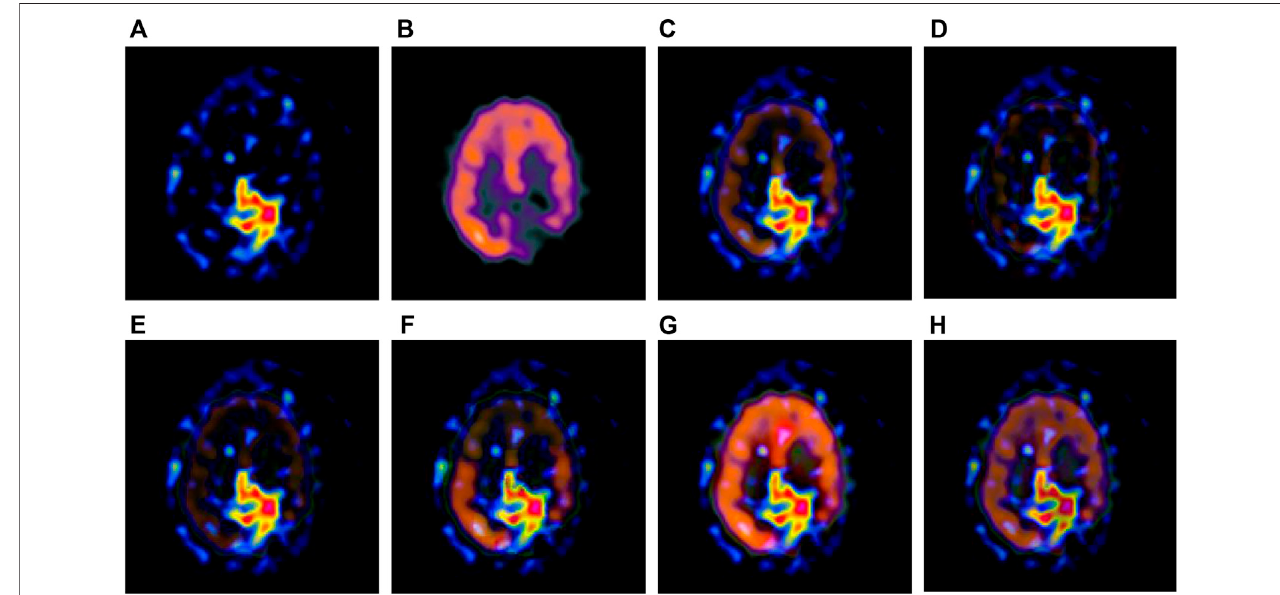
FIGURE3| Fusionresults ofthe fi rst group. (A) Source image SPECT-TL1 (B) Source image SPECT-TC1 (C) LaplacianPyramid (D) DWT-DBSS (E) SIDWT-Haar (F) Morphological Difference Pyramid (G) SR (H) GA-SR.